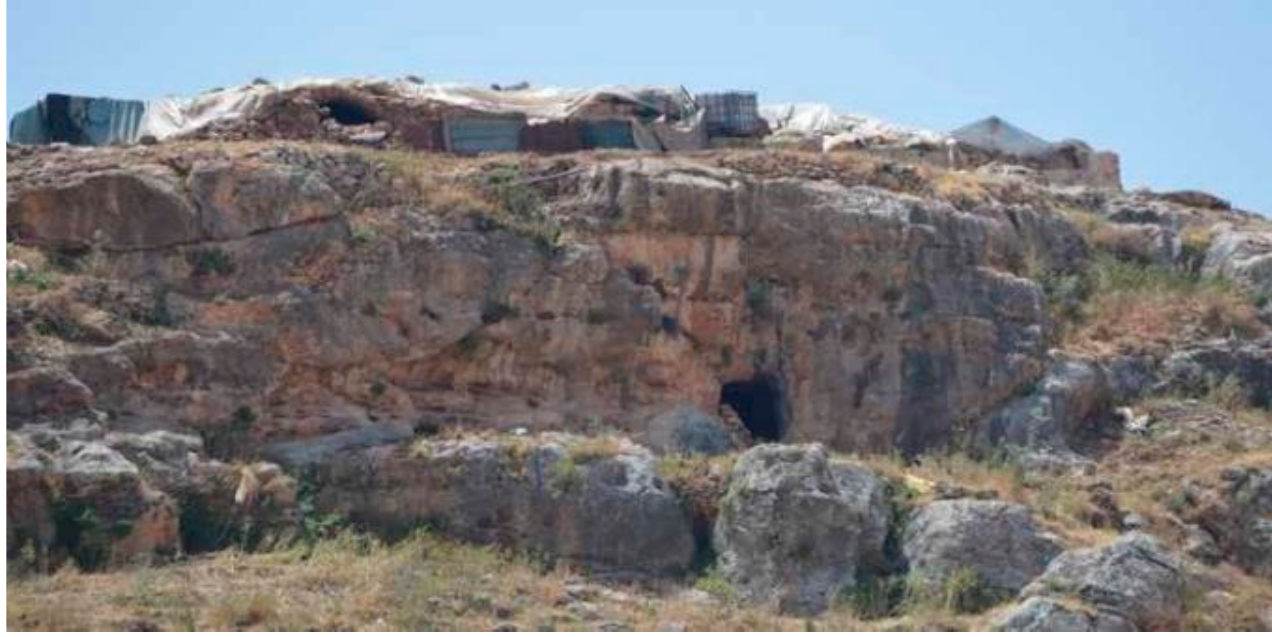
Figure 6. Animal sheds and the use of natural caves for animal keeping in WZ.